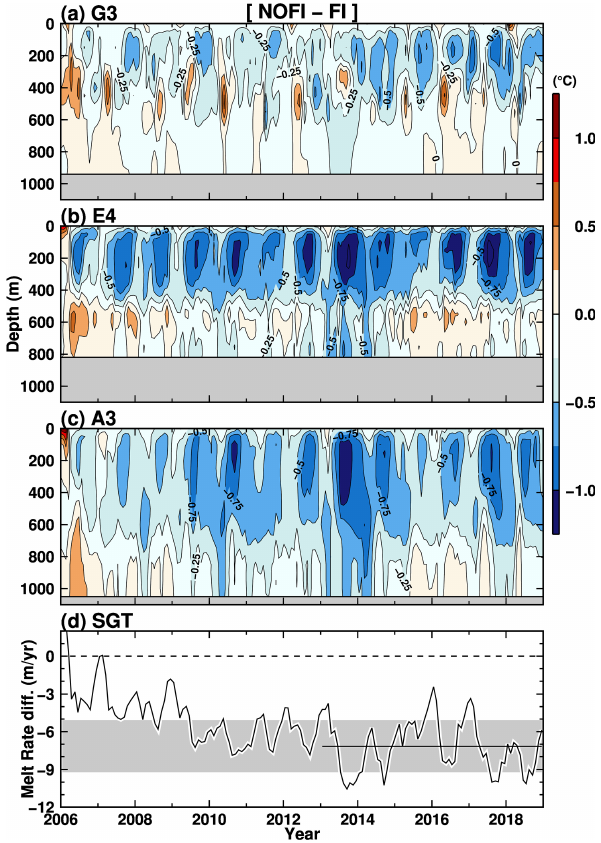
Figure 10. Time evolutions of the differences (NOFI − FI) in ocean temperature at the stations G3, E4, and A3 on the TROUGH section (Figs. 8 and 9), and the SGT basal melting. The black line and shade in panel (d) indicate the average of the SGT melt rate difference averaged over the period 2013–2018 between the FI and NOFI cases and the standard